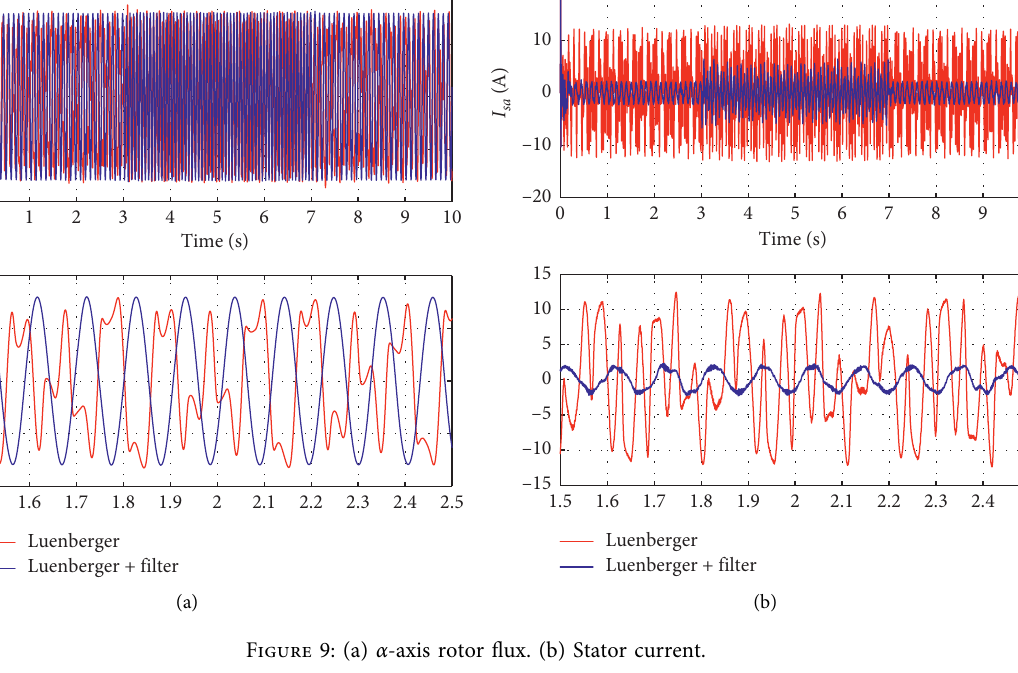
Figure 9: (a) α -axis rotor flux. (b) Stator current.